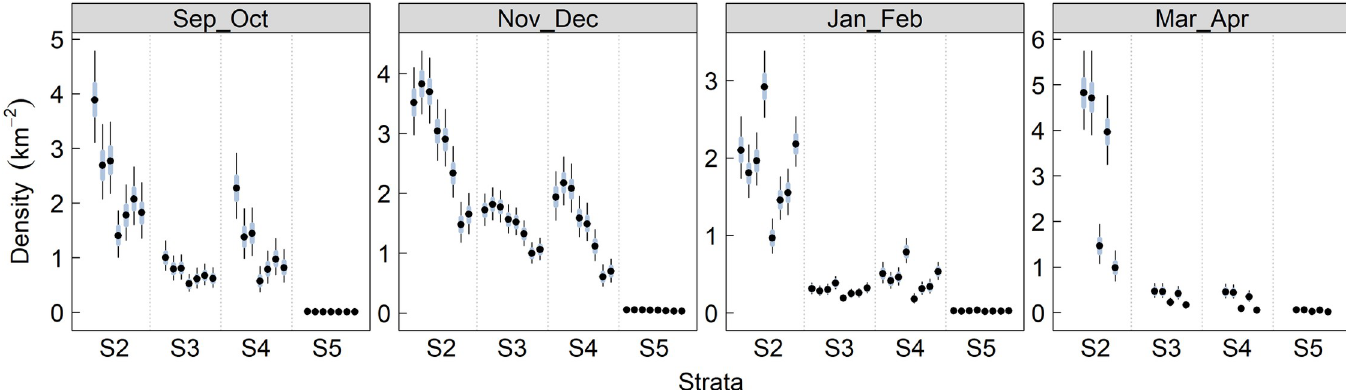
Fig 5. Relative marbled murrelet density for two 2-month breeding season survey intervals relative to that observed in the non-breeding season. A 100% relative density in May-Jun for a given year indicates that the density of murrelets was identical to that observed during the non-breeding season (Sep-Apr) and would suggest that birds are not moving into the region from outer coastal environments to molt and over-winter as we predicted. However, if the May-Jun density were 50% of that observed during the non-breeding season, then there would be evidence for movement into the region during the non-breeding